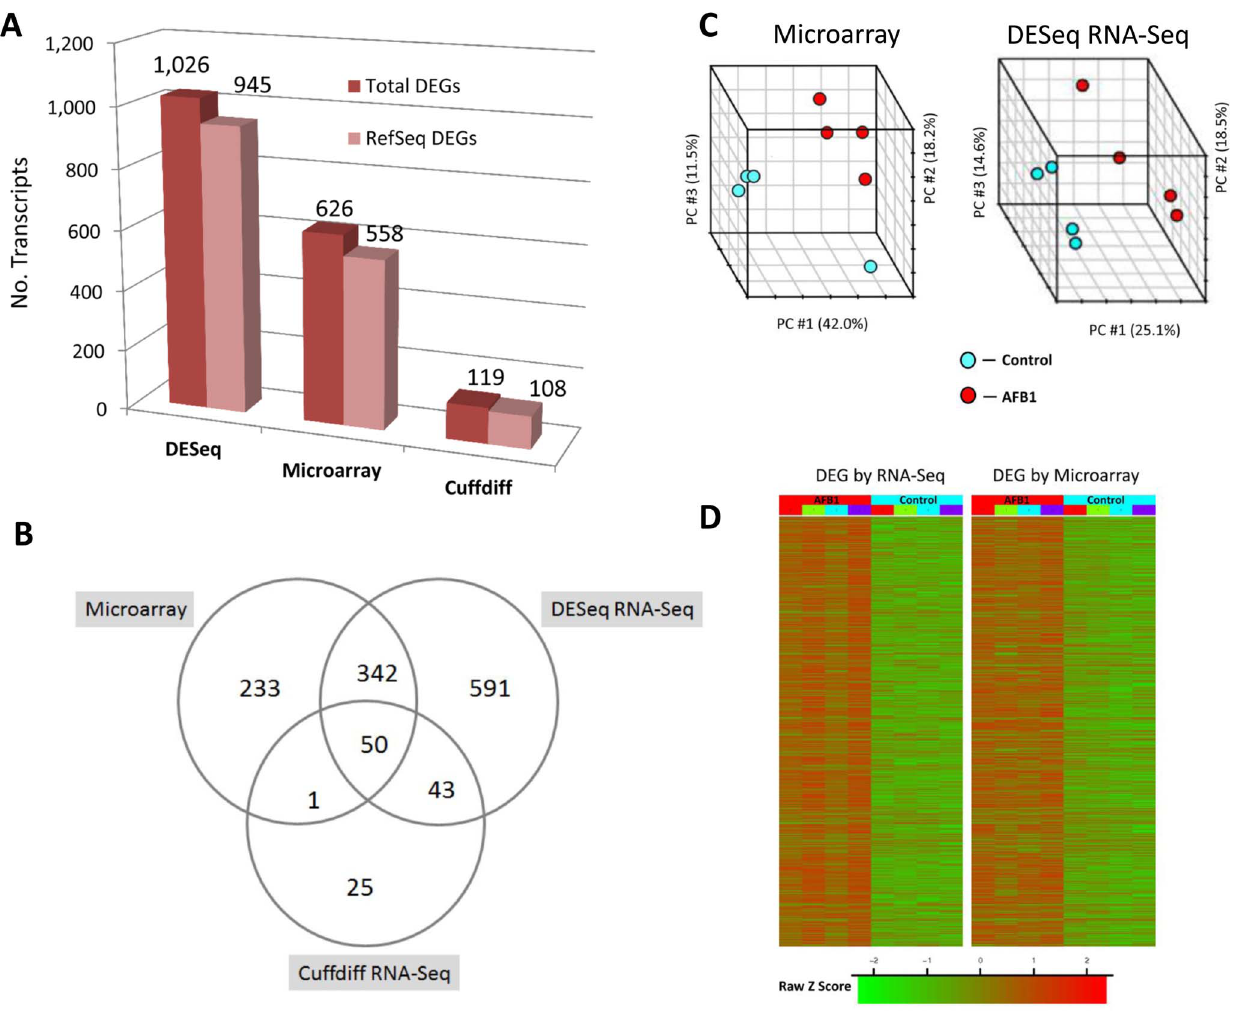
Figure 1. Differentially expressed genes (DEGs) identified from RNA-Seq by DESeq and Cuffdiff compared to microarray. Panel A. Number of DEGs observed with change $ 2-fold at p # 0.005 by DESeq, microarray and Cuffdiff analyses with Cufflinks assembled transcripts for all eight animals (4 Control, 4 AFB1) is shown. Total number of Cufflinks assembled transcripts and those that match an existing RefSeq annotation are displayed in the bar chart. Panel B. Venn diagram of DEGs from Panel A shows the number of common transcripts (overlapping circles) and unique transcripts (non-overlapping circles) for all three analyses. Panel C. Principal component (PC) analysis was performed for all samples using the gene expression values for DEGs found by microarray and DESeq (on Cufflinks assembled transcripts) analysis. The percentage variability captured by the first three principal components is displayed across PC # 1, 2 and 3 represented on X, Y and Z axes. Panel D. Heatmap shows all DEGs at $ 2-fold change, p # 0.005 from microarray or DESeq analyses (on Cufflinks assembled transcripts). Gene expression data were log2 transformed and then quantile normalized prior to generating the Heatmap for direct comparison of data. DEGs (red or green are upregulated or downregulated, respectively) for each animal were mapped by lane for each of four animals in the CNTL or AFB1 treatment